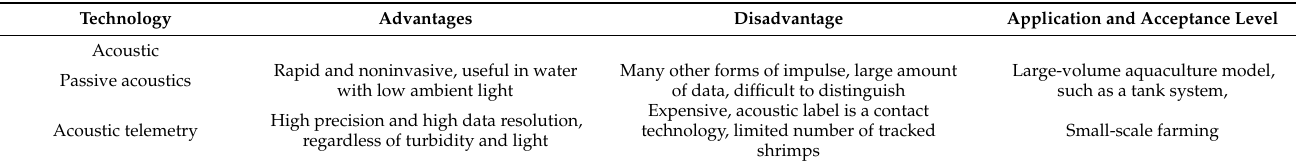
Table 4. Advantages and disadvantages of different automatic monitoring